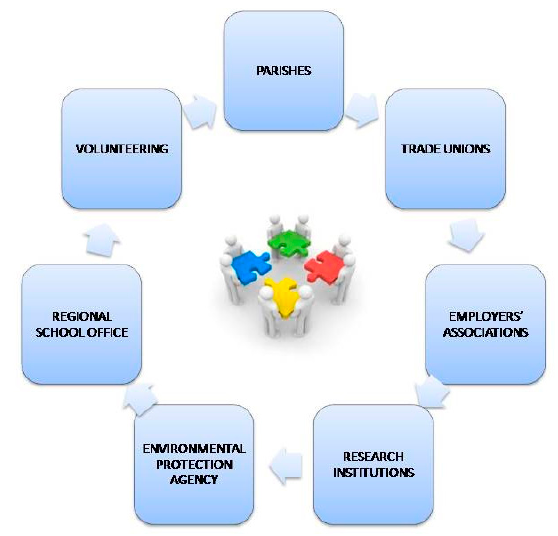
Figure 3. Different categories of target social actors of the territorial survey .